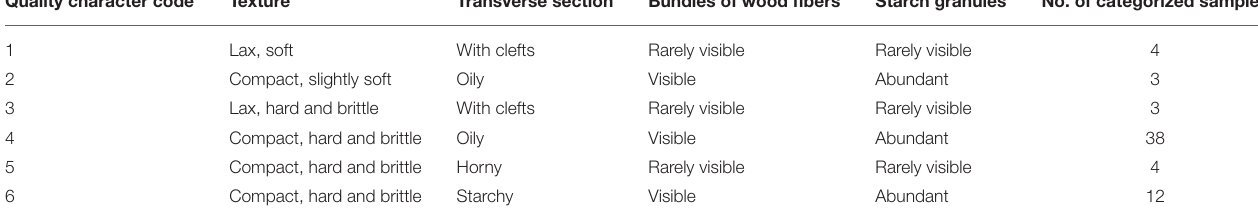
TABLE 2 | Quality characters of Isatidis Radix and number of the categorized samples. Quality character code